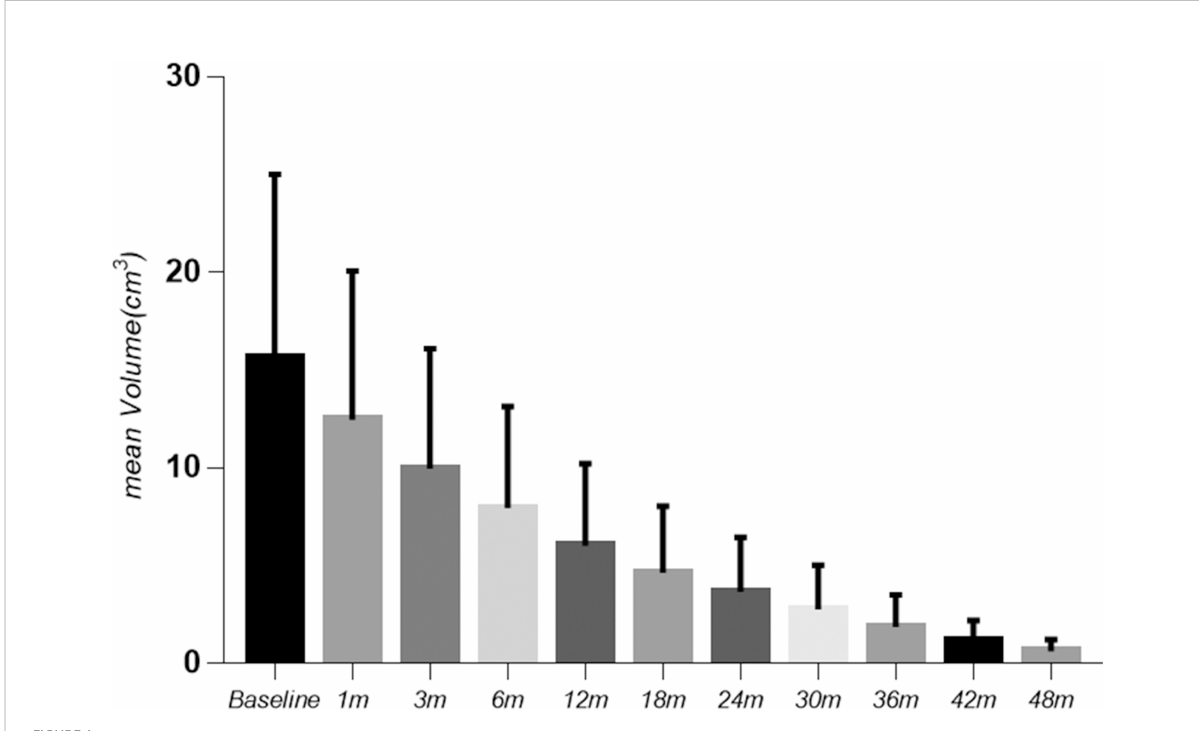
FIGURE 1 Variation in the mean volume before and after MWA at each follow-up